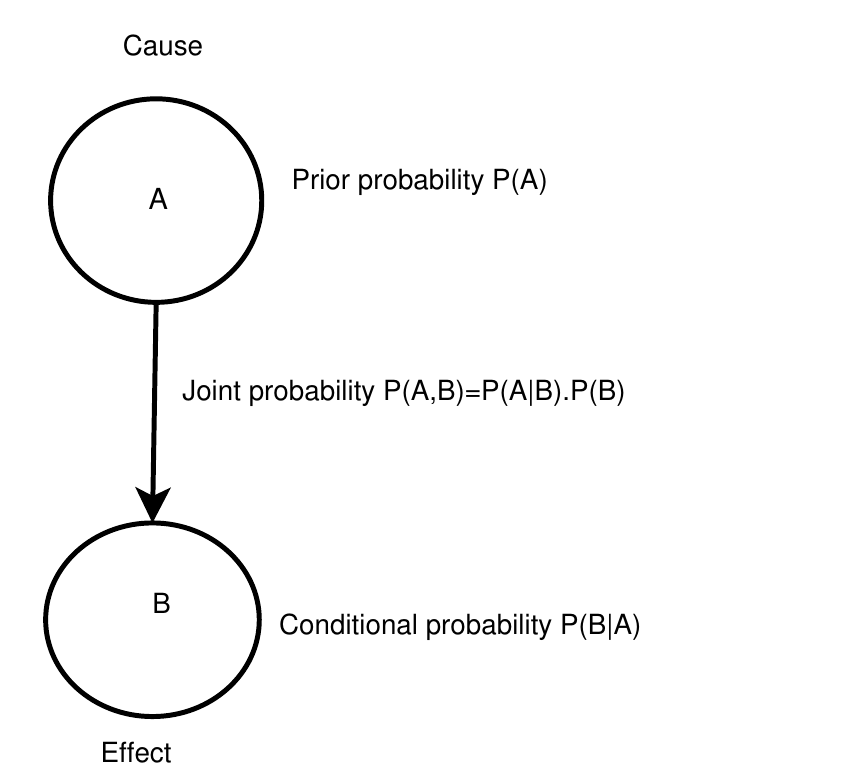
Figure 1. Cause–effect relationships. An outgoing edge from node A to B indicates a causal relation between these two nodes, in which the value of B is dependent on the value of A. A is the parent node of B and B is a child node of A. A conditional probability attached to node B is conditioned on the set of all parents of node B, pa ( B ) , and is represented by P ( B | pa ( B ))